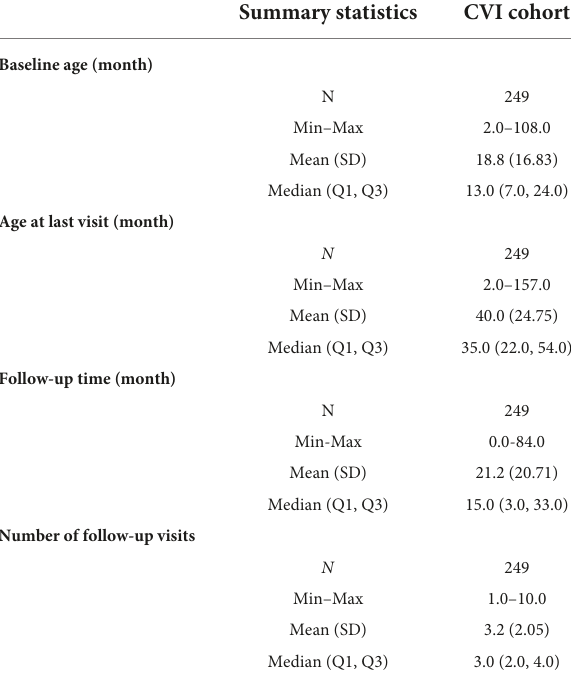
TABLE 1 Summary of patient age and follow-up